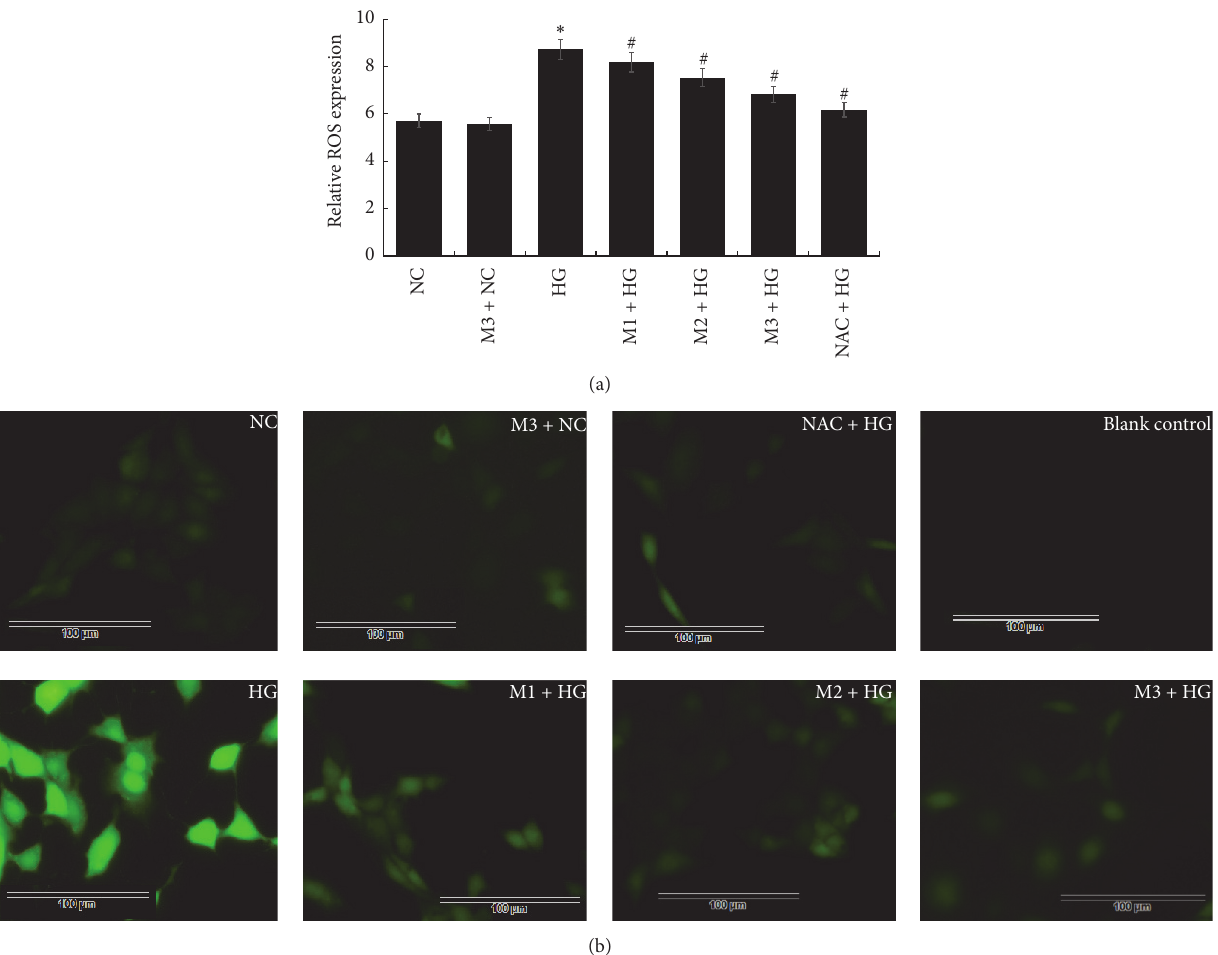
Figure 5: (a) DCFH-DA detected the expression of ROS in GMC after the treatment of NAC and maresin 1; ∗ 𝑃 < 0.05 versus NC group, # 𝑃 < 0.05 versus HG group. (b) GMCs were stained with DCFH-DA probe and images were captured using fluorescence microscope. Compared with NC group, the ROS generation increased in HG group, but it decreased in NAC + HG and M + HG group in a concentration-dependent